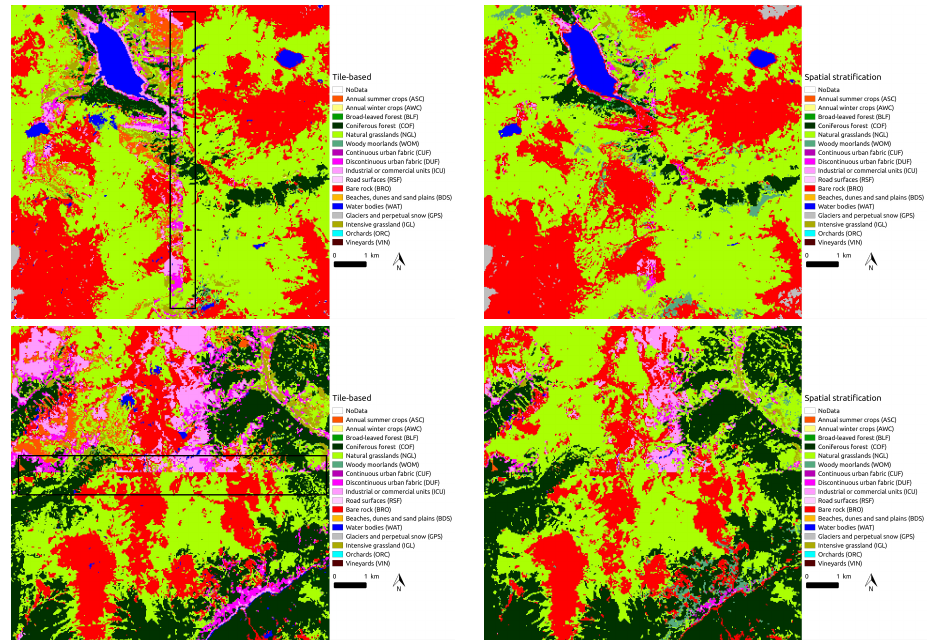
Figure 23. Analysis of artefacts due to tiling. Tile transitions with important artefacts are indicated with black rectangles.